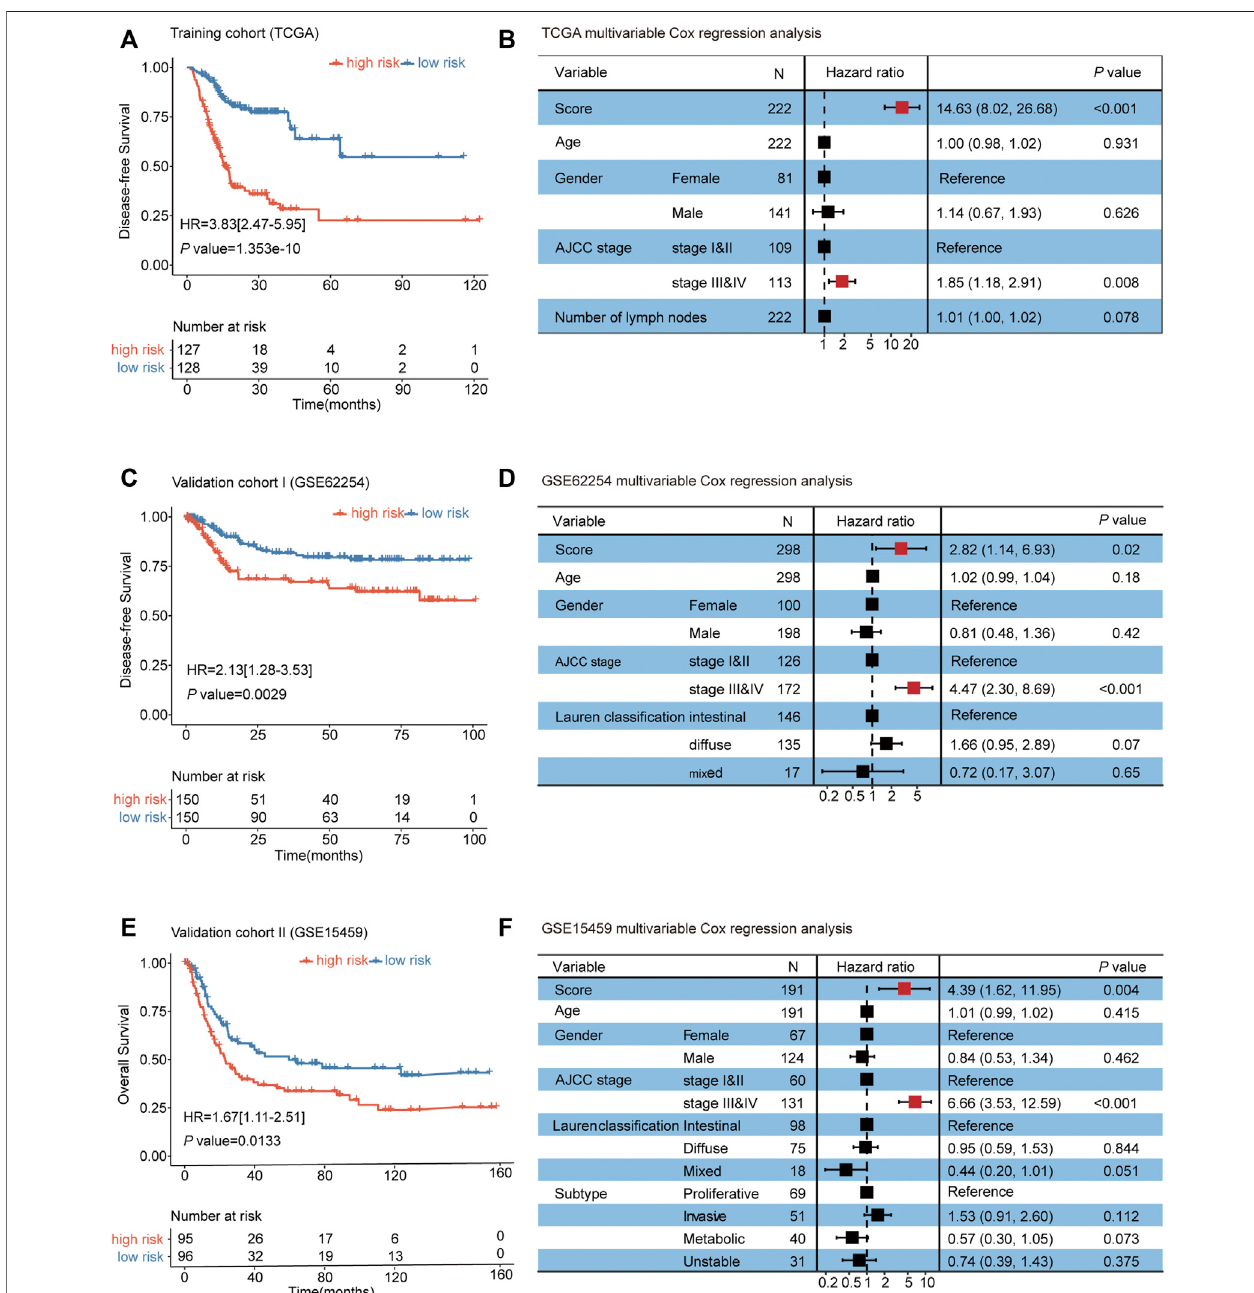
FIGURE 2 | Establishment and validation of an autophagy-related risk score for predicting the prognosis of gastric cancer. (A) Kaplan – Meier curves for TCGA patients( n (cid:1) 255). (B) Multivariable Coxregressionanalysisofthe riskscore, age,gender,AJCC stage, and number oflymphnodes onTCGA. (C) Kaplan – Meier curves forGSE62254patients( n (cid:1) 300). (D) MultivariableCoxregressionanalysesoftheriskscore,age,gender,AJCCstage,andLaurenclassi fi cationonGSE62254datasets. (E) Kaplan – Meier curves for GSE15459 patients ( n (cid:1) 191). (F) Multivariable Cox regression analyses of the risk score, age, gender, AJCC stage, Lauren classi fi cation, and subtype on GSE15459 datasets. The differences between the two curves were determined by the two-sided log-rank test. The squares on the transverselinesintheforestplotrepresentthehazardratio(HR),andthetransverselinesrepresent95%CI.Riskscore,age,andnumberoflymphnodesarecontinuous variables; gender, AJCC stage, Lauren classi fi cation, and subtype are discontinuous variables.